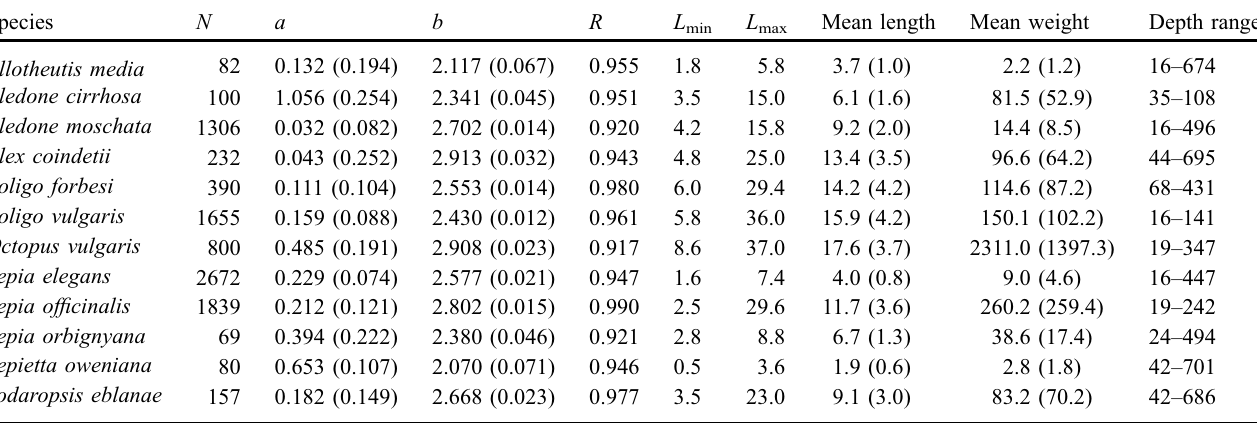
Table 2. Parameter estimates of the length – weight relationship for the selected cephalopod species in the Gulf of Cadiz: N (sample size), a intercept (CV by bootstrap), b slope (CV by bootstrap) and R coef fi cient of determination. Lengths are presented for dorsal mantle length (cm): L min minimum observed length, L max maximum observed length and mean length (SD), and weights are mean wet weights in g (SD). Depth range (m) is also shown for each species in the study